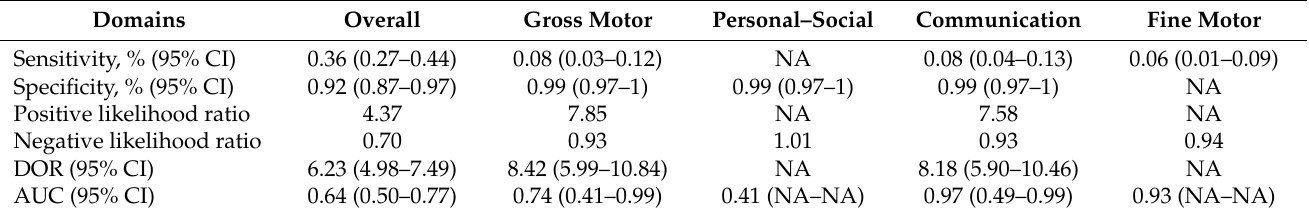
Table 5. Subgroup analysis of the classification performance of the Ages and Stages Questionnaire— Third Edition in children with a high maternal education